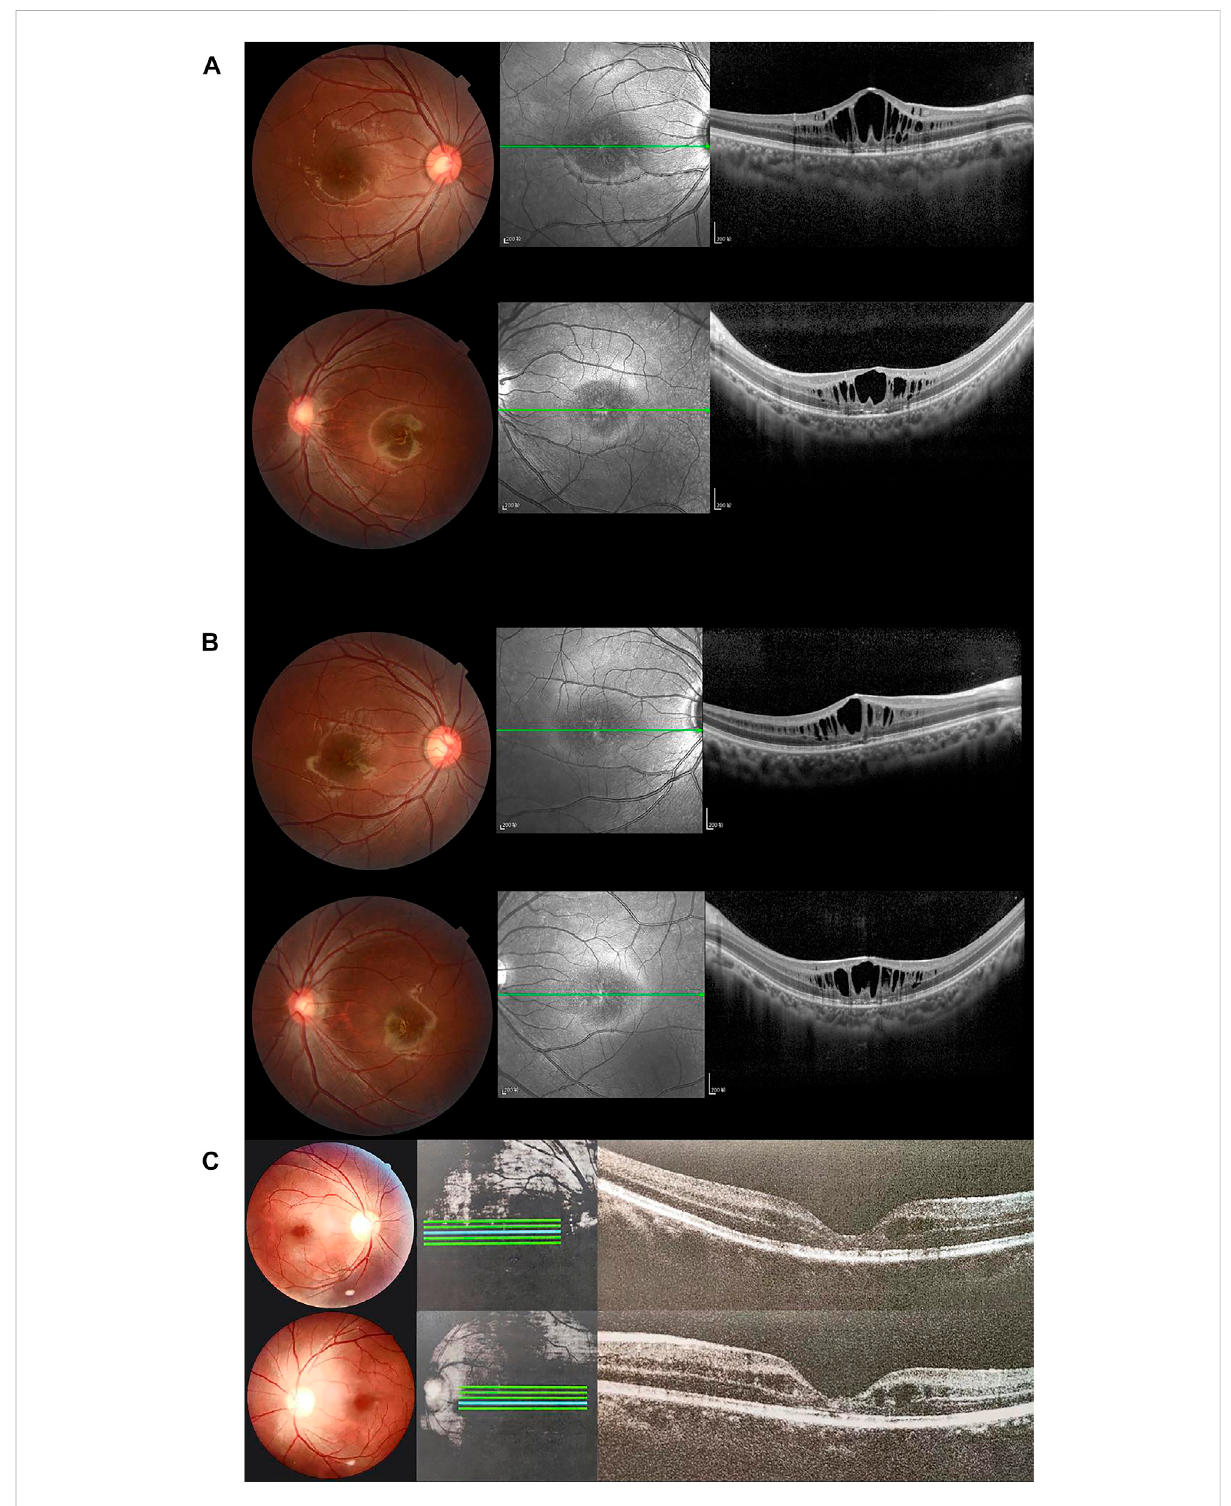
FIGURE 2 Fundus photographs and optical coherence tomography (OCT) images of patients and healthy subjects. Right eye (above), left eye (below). (A) Fundus photographs and OCT fi ndings of fovea schisis of Ⅲ :5. (B) Fundus photographs and OCT fi ndings of fovea schisis of III:6. (C) Fundus photographs and OCT fi ndings of fovea schisis of II:3. (D) Fundus photographs and OCT fi ndings of normal fundus of II:6. (E) Fundus photographs and OCT fi ndings of normal fundus of II:5. (F) Fundus photographs and OCT fi ndings of normal fundus of